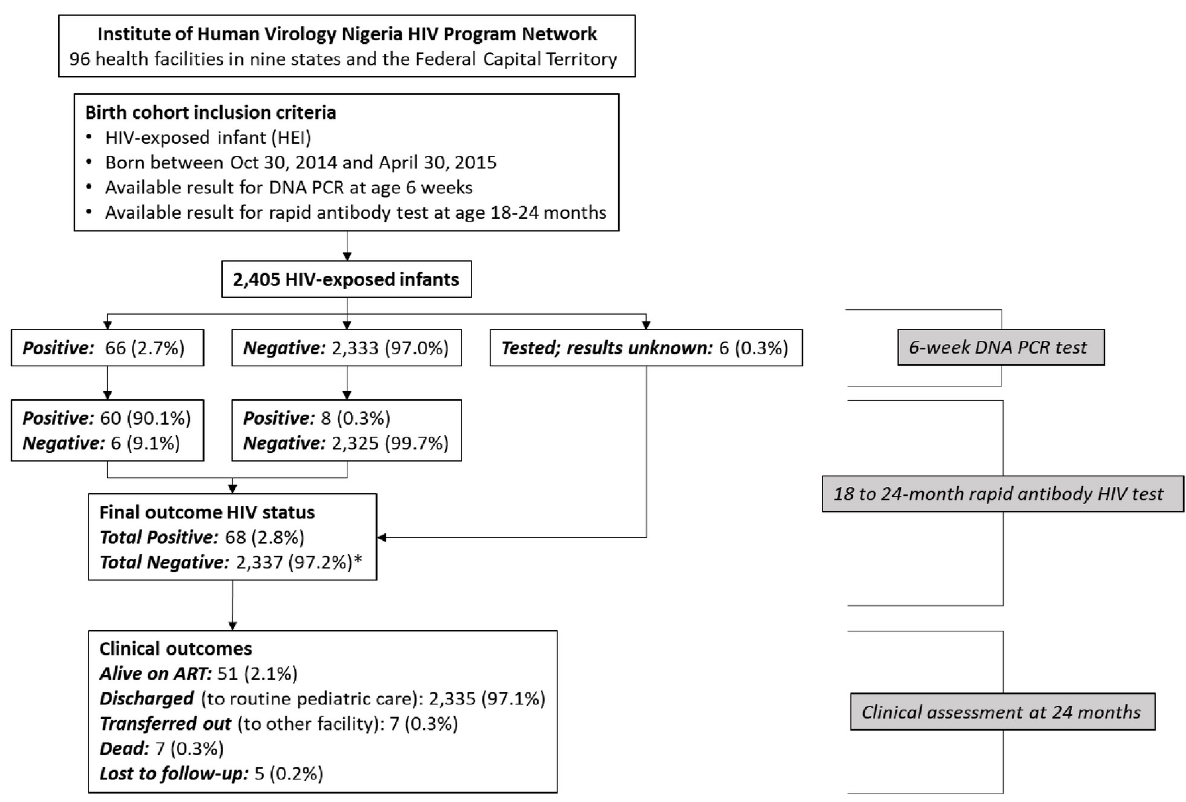
Fig 1. Flow chart for HIV-exposed infants from early diagnosis to final outcome. � Includes 6 infants with unknown 6-week DNA PCR results who subsequently tested negative at 18 to 24-month final outcome assessment.